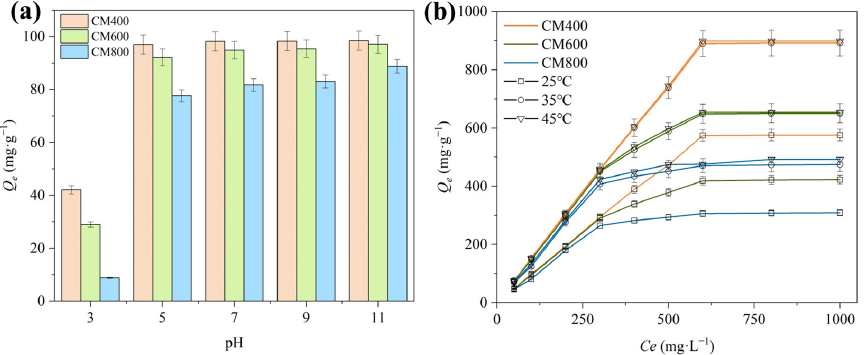
Figure 3. The effect of pH and temperature on the adsorption. ( a ) pH and ( b ) temperature. Experimental conditions: [initial concentration of Pb(II)] = 100 mg · L − 1 , [dosage] = 1 g · L − 1 .